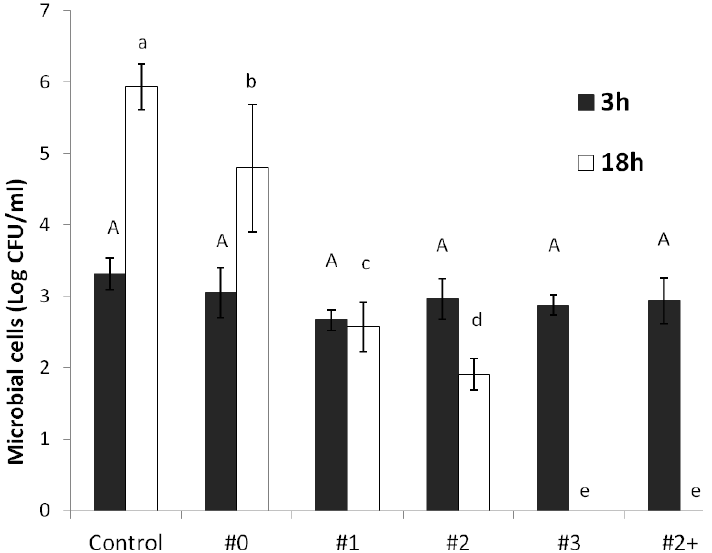
Figure 5. Effect of TiO 2 on growth of E. coli O157:H7. The bacterial populations on the surfaces of the films were determined after 3 (black colimn) and 18 h (white column) under FL irradiation. Control: no coating. Each tested Petri dish coated with 10 mL TiO 2 /zein formulation. The ratio of TiO 2 /zein in sample #0: 0 (neat zein); sample #1: 1%; sample #2: 2%; sample #3: 10%; sample #2 + : double-layer film,